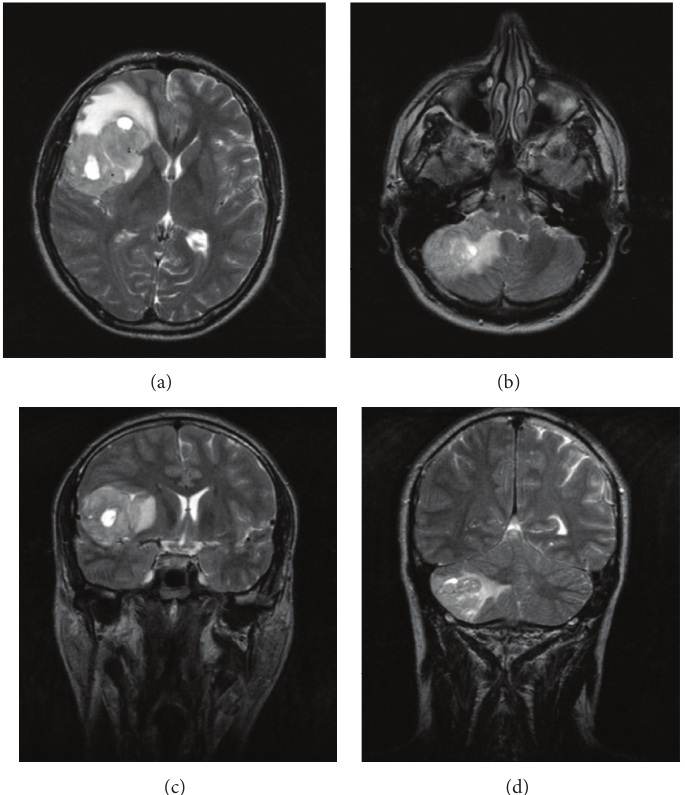
Figure 3: Axial and coronal T2-weighted images showing inhomogeneous hyperintensity of the cerebellar and fronto-temporal right lobe lesions associated with ovalar hyperintensities and perilesional